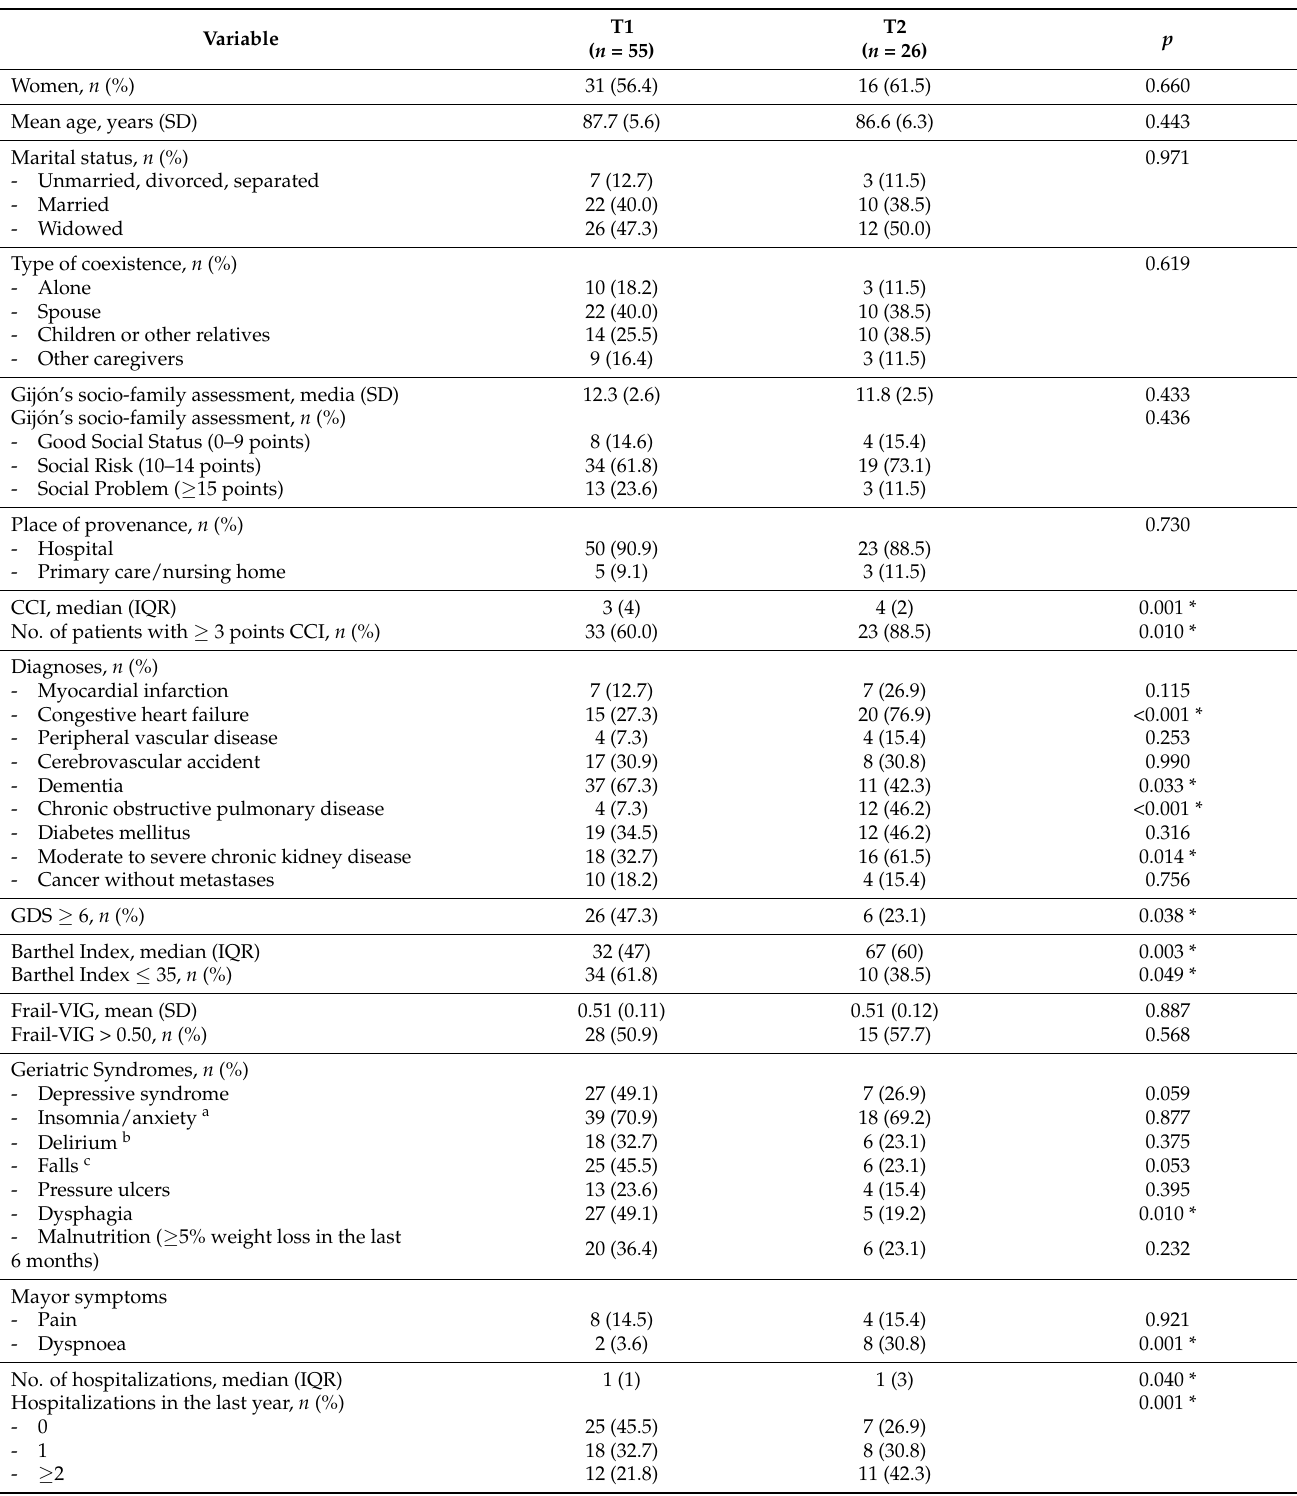
Table 1. Cohort baseline data according to illness